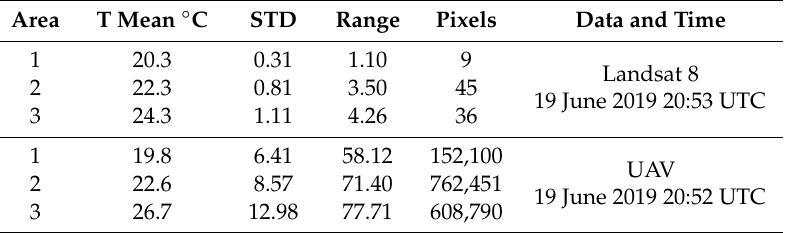
Table 6. Statistical analysis for June